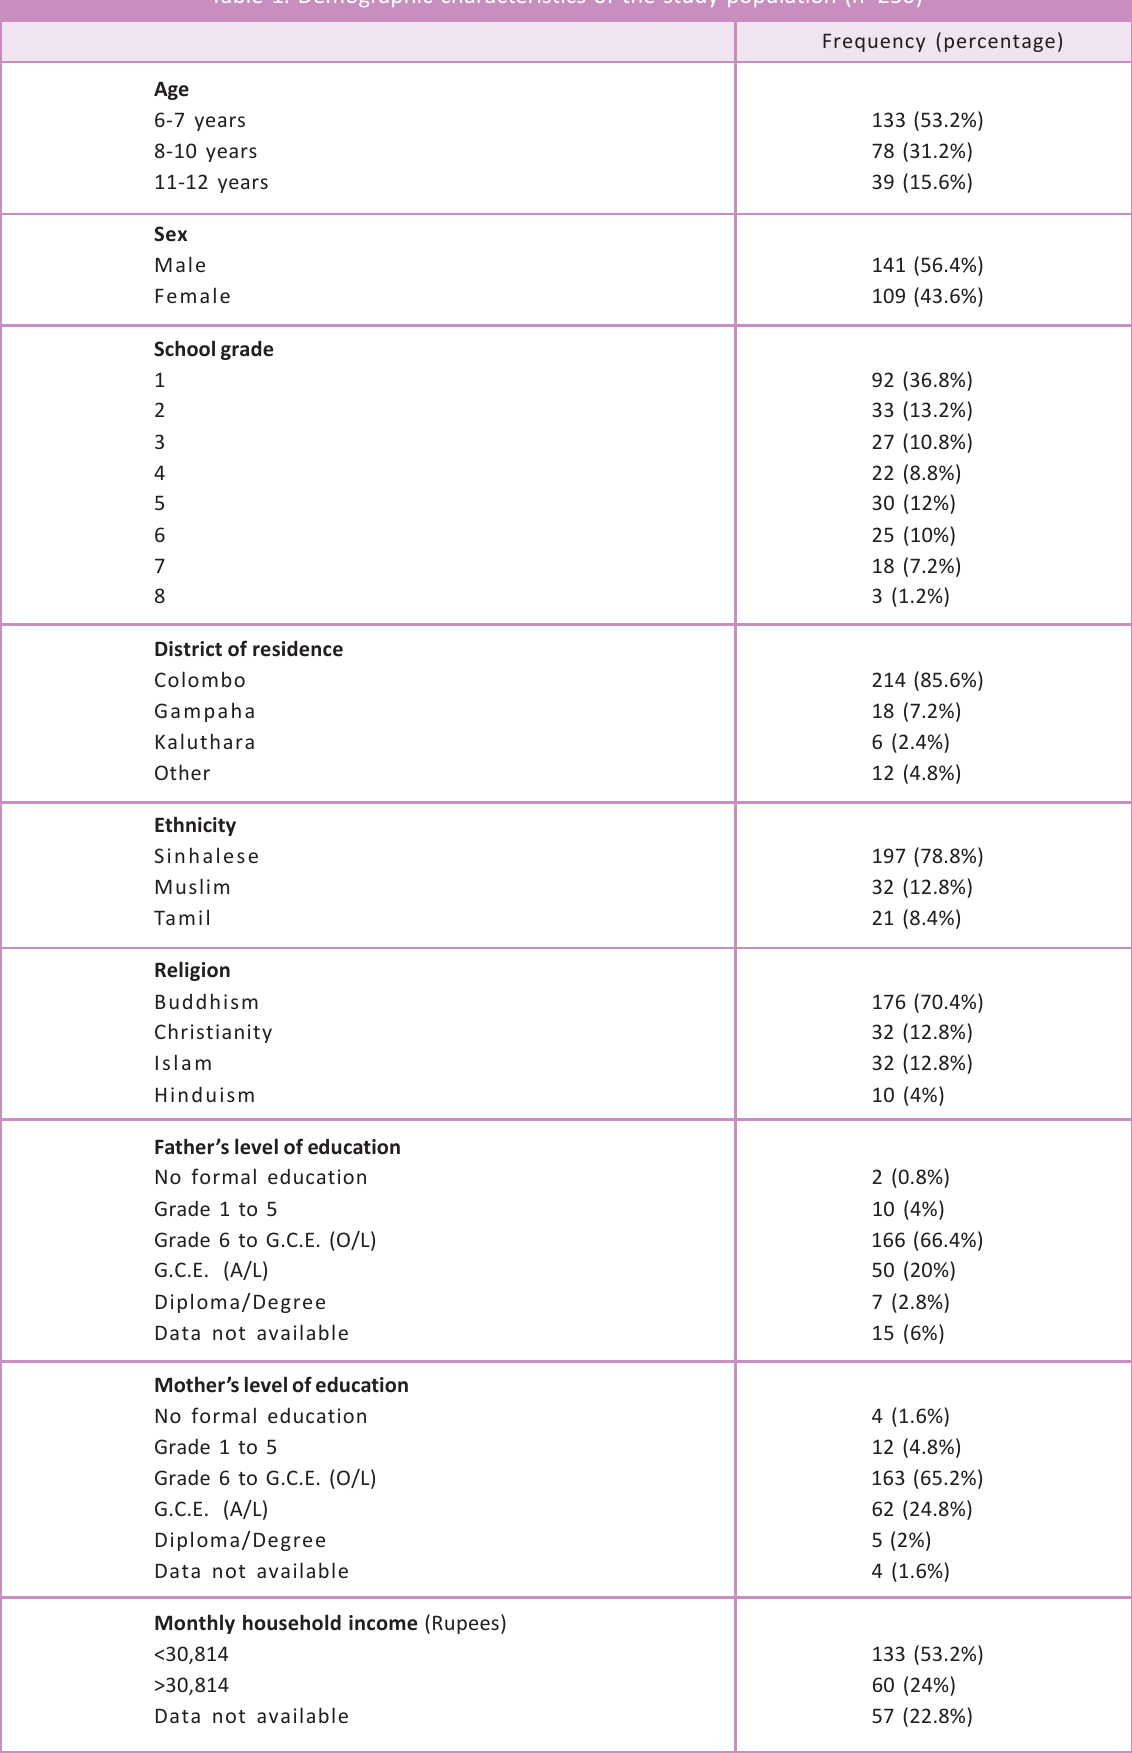
Table 1. Demographic characteristics of the study population